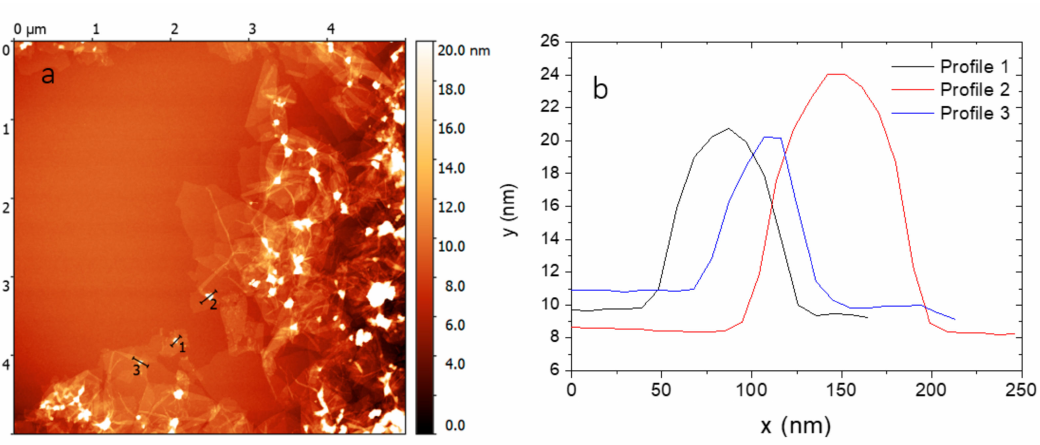
Figure 5. Modified graphene oxide platforms by magnetic nanoparticles: ( a ) atomic force microscopy (AFM) image, and ( b ) selected height profiles across the magnetic